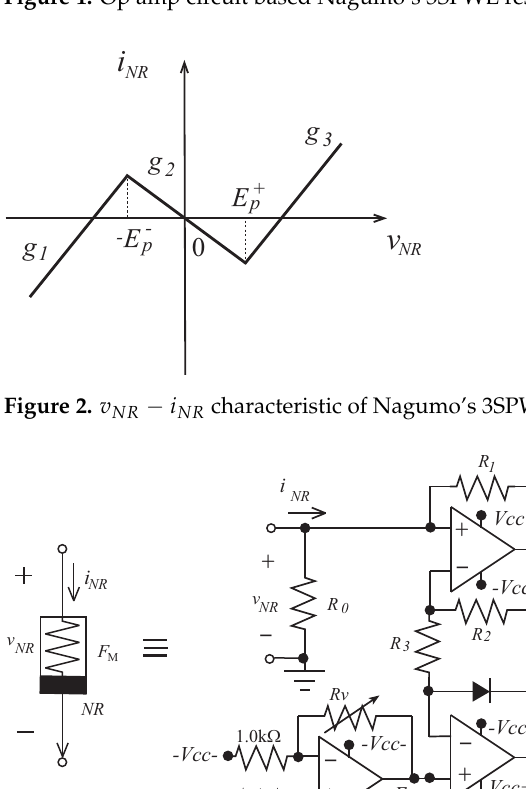
Figure 1. Op amp circuit based Nagumo’s 3SPWL resistor.